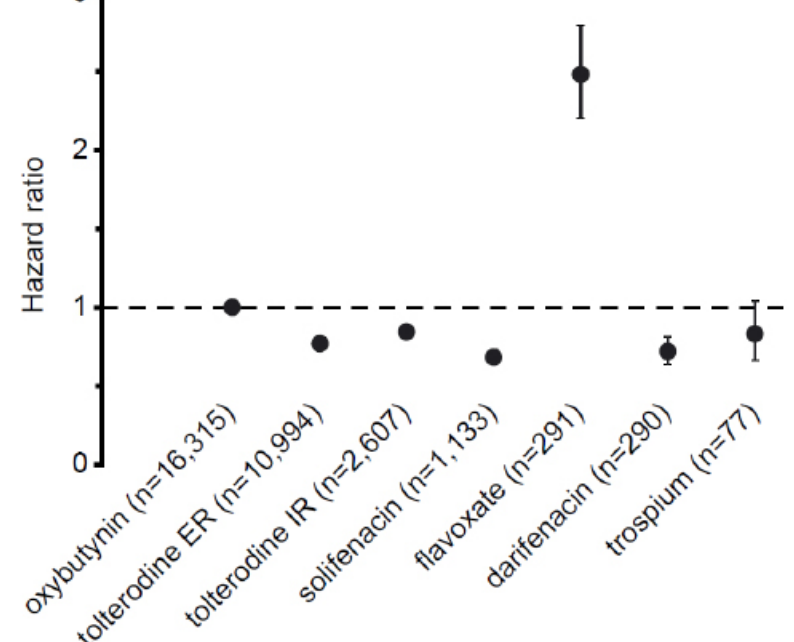
Figure 3. Hazard Ratios for Risk of Discontinuation According to First-prescribed OAB